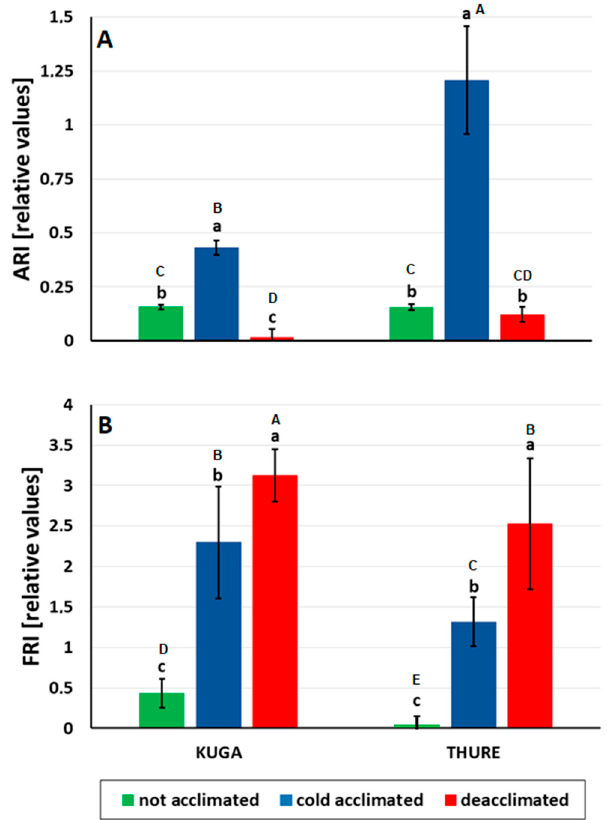
Figure 4. Level of anthocyanins (parameter ARI; ( A )) and flavonols (parameter FRI; ( B )) that were calculated based on the leaf reflectance measurements for the not acclimated, cold-acclimated, and deacclimated oilseed rape cv. Kuga and cv. Thure. Mean values ± SD marked with the same letters did not differ significantly at p ≤ 0.05 according to Duncan’s test, n = 10; lowercase—comparison separately within each cultivar, uppercase—comparison between cultivars.